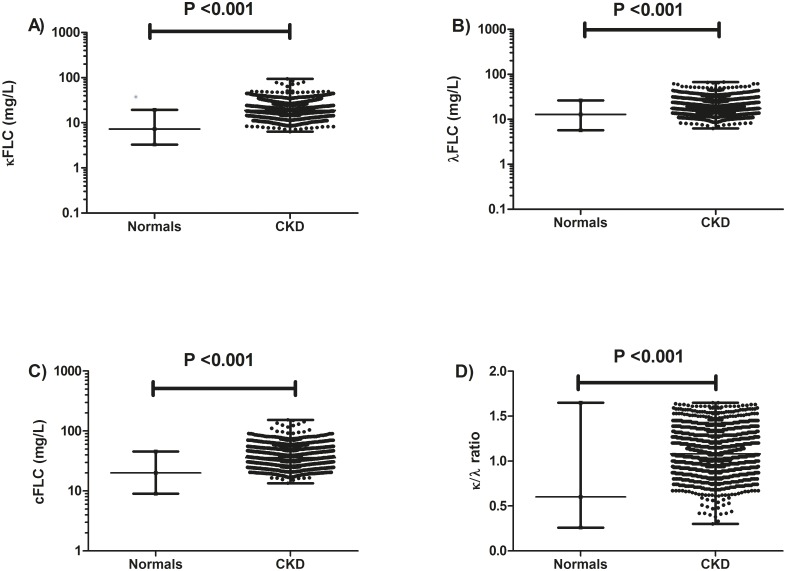
Serum FLC concentration in people with stage 3 chronic kidney disease versus normal controls.A) κfree light chains (FLC), B) λFLC and C) Combined free light chains (cFLC) levels were elevated in people with chronic kidney disease (CKD) (circles) versus published normal control individuals [21]. D) The FLC κ/λ ratio was also significantly higher in people with CKD compared to the healthy control population. Median and ranges are indicated (black bars).